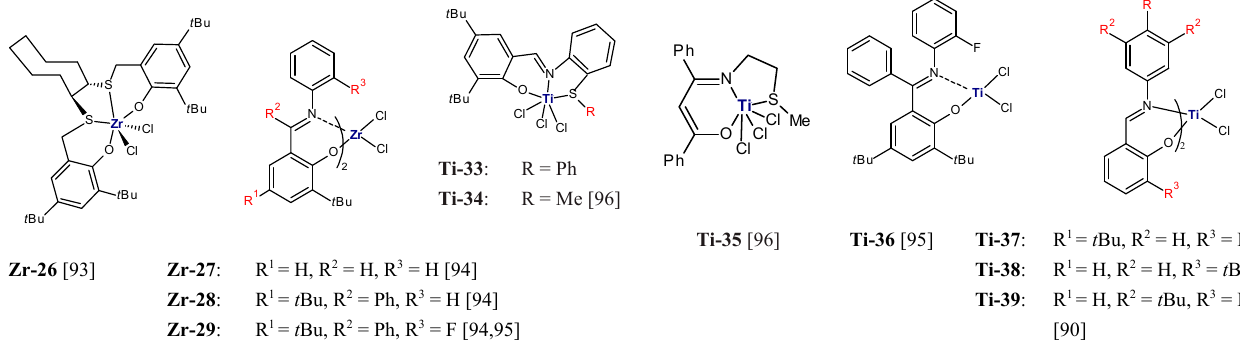
Figure 8. Titanium and zirconium complexes investigated as precatalysts for ethylene/ α , ω -alkenols copolymerization [90,93–96].